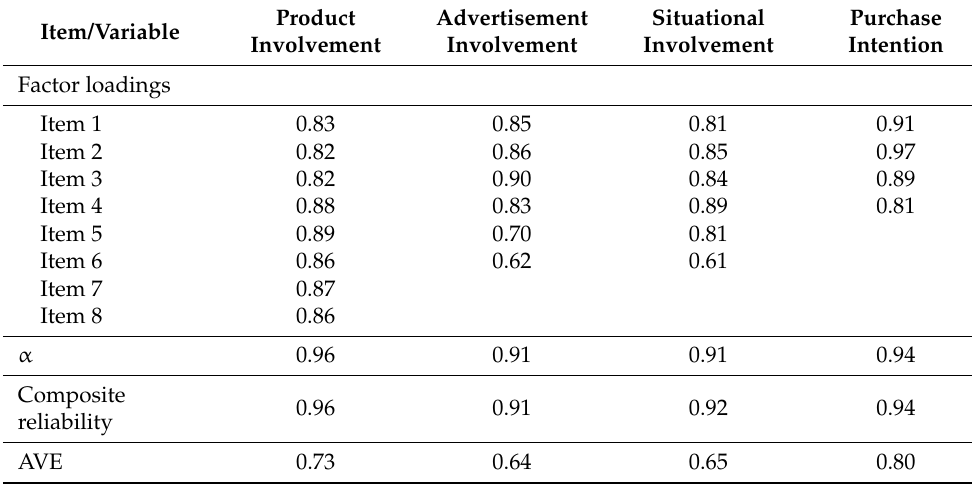
Table 2. Confirmatory factor analysis ( n = 1046).